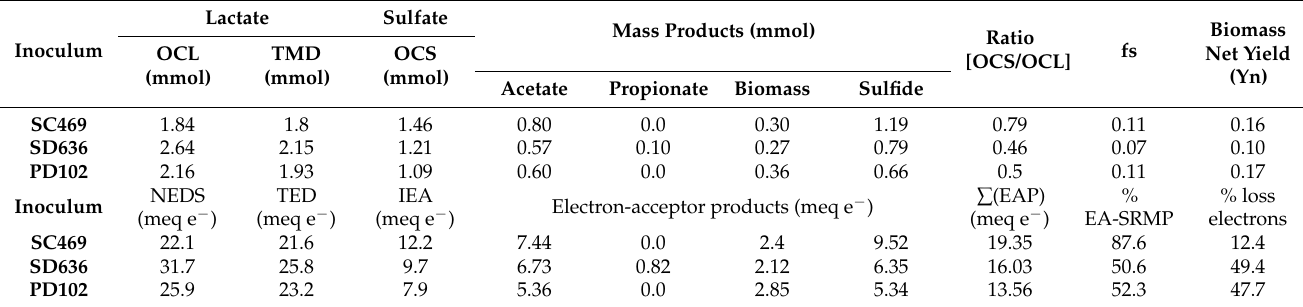
Table 5. Mass and electron balances between lactate and products associated with different lactate biodegradation